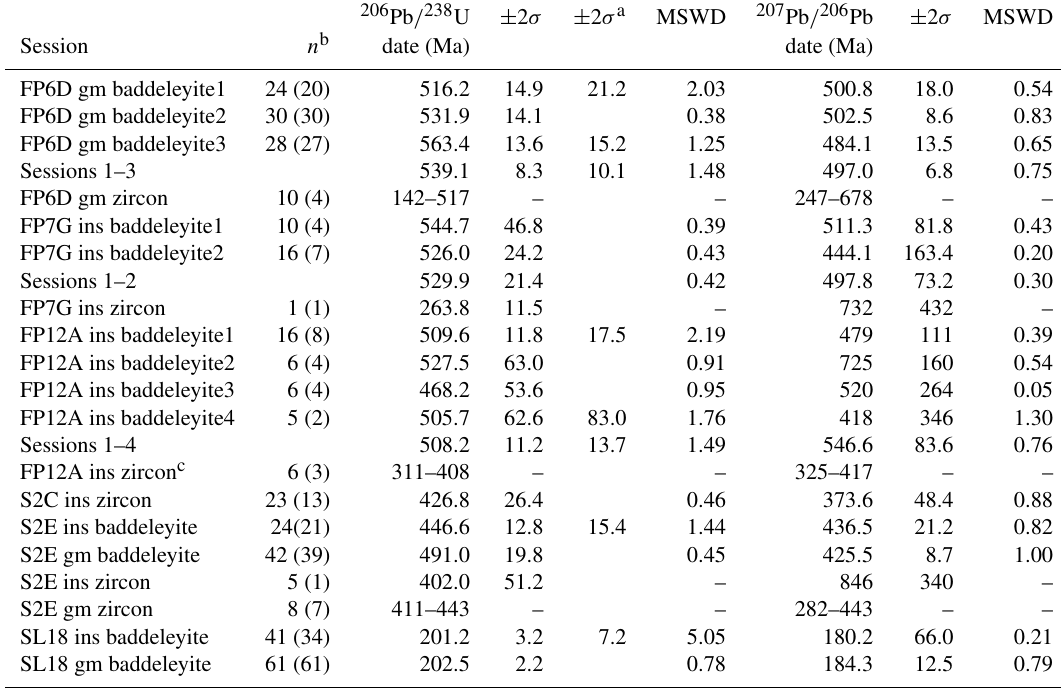
Table 2. Summary of U–Pb SIMS results (see Tables S1–S6 for the detailed